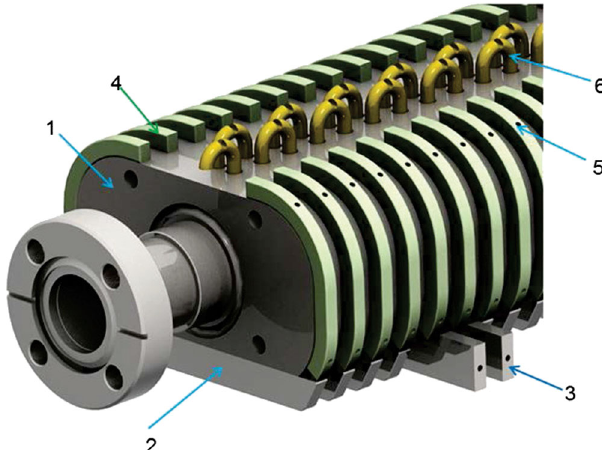
FIG. 3. SCU1 undulator upper magnet core. Core components: core body (1); magnetic poles (2); magnetic poles with the end tabs (3); G10 side spacers (4); spring pins (5); conductor turn around pins (6). The flanged pipe is for liquid helium